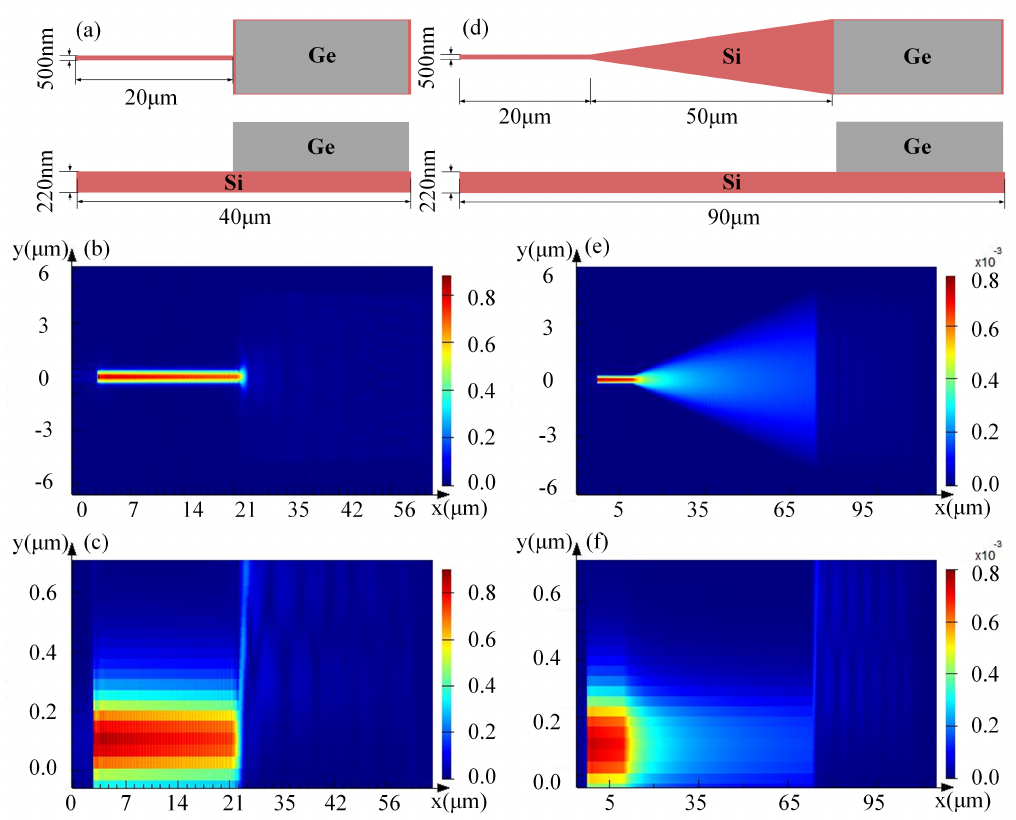
Figure 2. Structure and field diagram of Ge waveguide detector. ( a ) Overhead and elevation views without taper structure. ( b ) Transverse optical field distribution of Si waveguide without taper structure. ( c ) Longitudinal optical field distribution of Si–Ge waveguide without taper structure. ( d ) Overhead and elevation views of Si taper structure. ( e ) Transverse optical field distribution of Si waveguide with Si taper structure. ( f ) Longitudinal optical field distribution of Si–Ge waveguide with Si taper